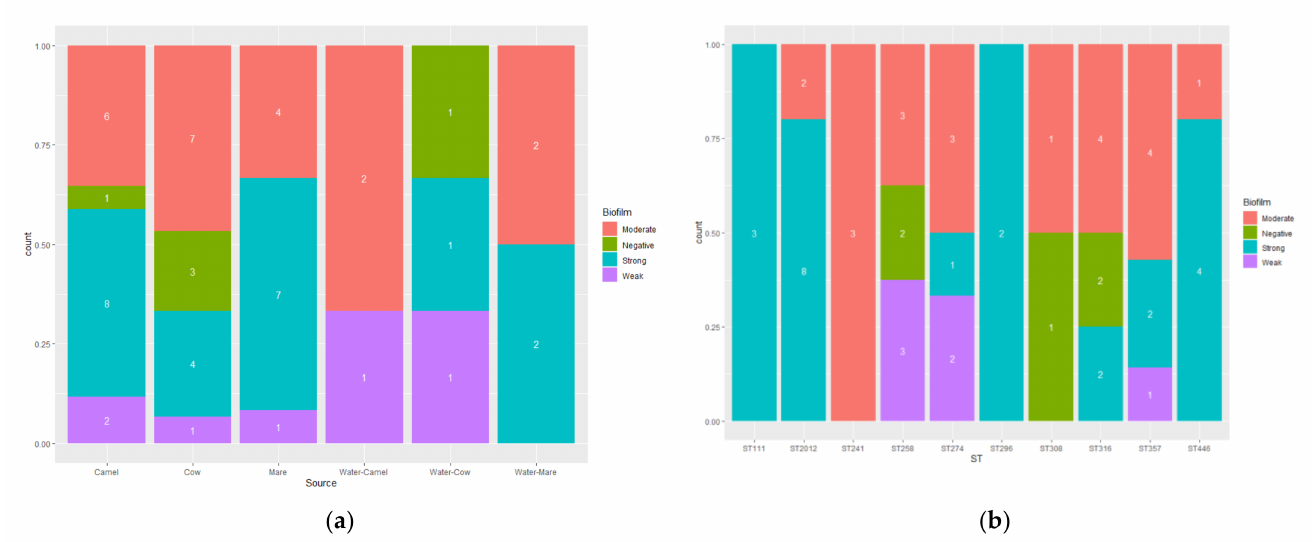
Figure 4. The frequency of the biofilm strength (negative, weak, moderate and strong) among the P. aeruginosa isolates ( n = 54) with regard to the isolation source ( a ) and the isolate sequence type ( b ).